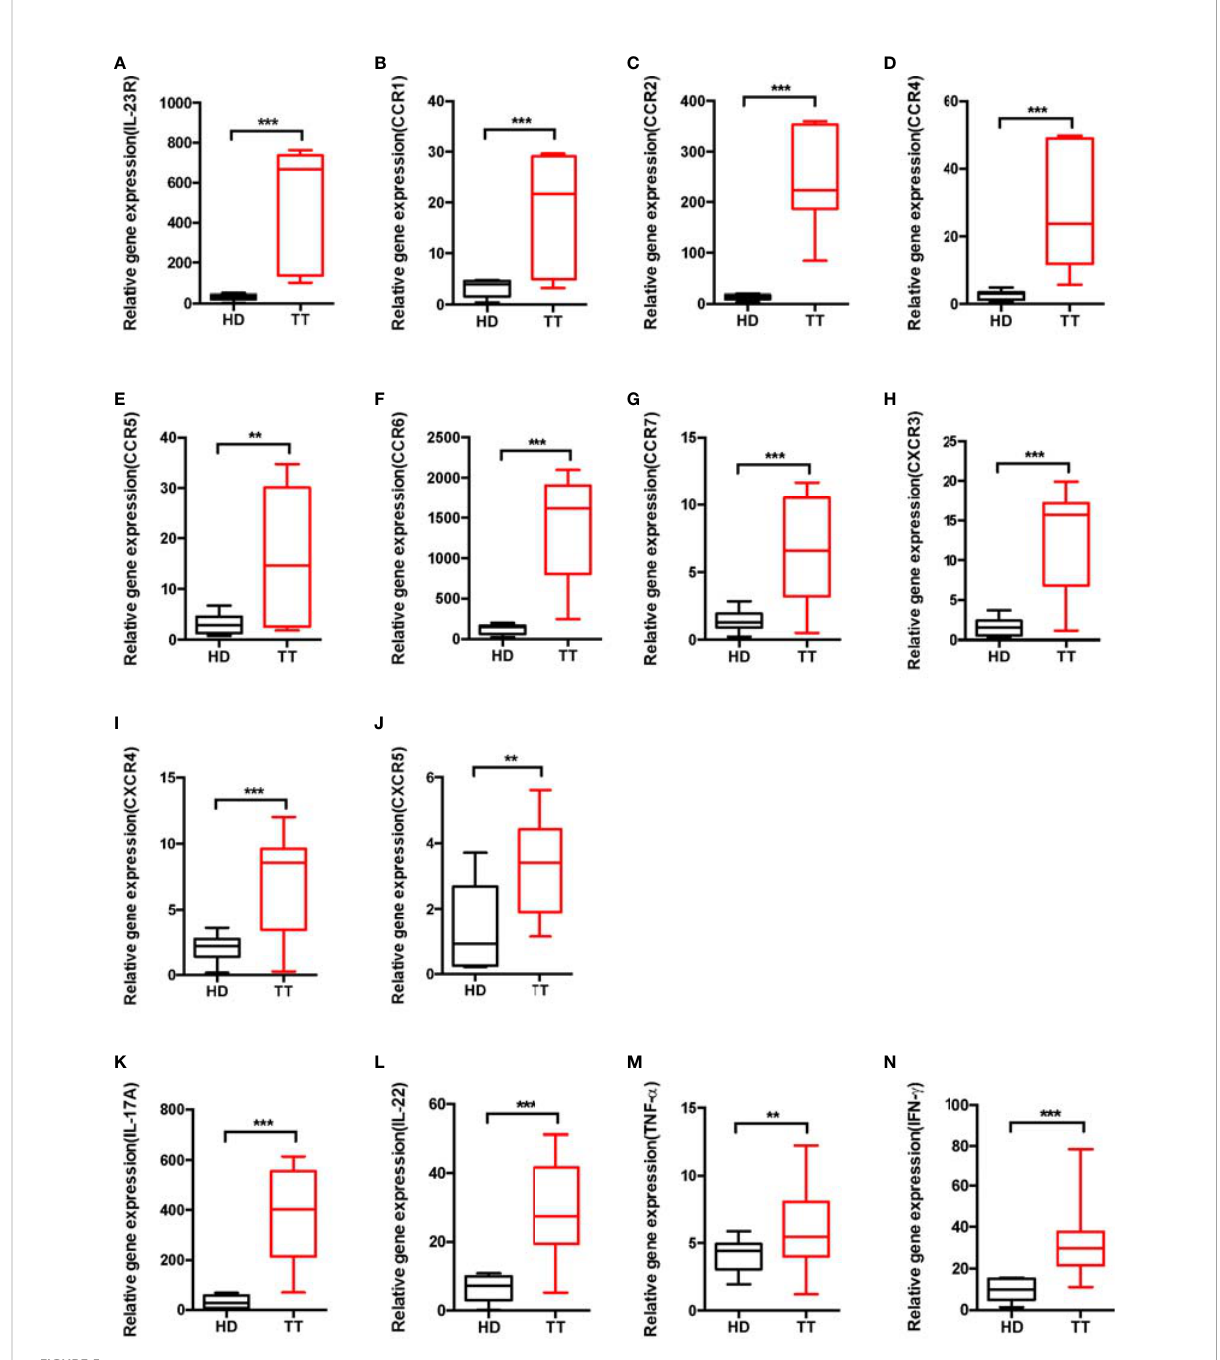
FIGURE 5 Phenotypic analysis of dermal gd T cell in leprosy lesions. (A – J) Expressions of IL-23R and chemokine receptors mRNA were measured by qPCR. (K – N) mRNA expression levels of cytokine produced by dermal gd T cells were measured by qPCR. Relative gene expression indicated gene normalized for b-actin and was shown as mean ± SEM. Statistical analysis was performed by t -test. ** p < 0.01; *** p <